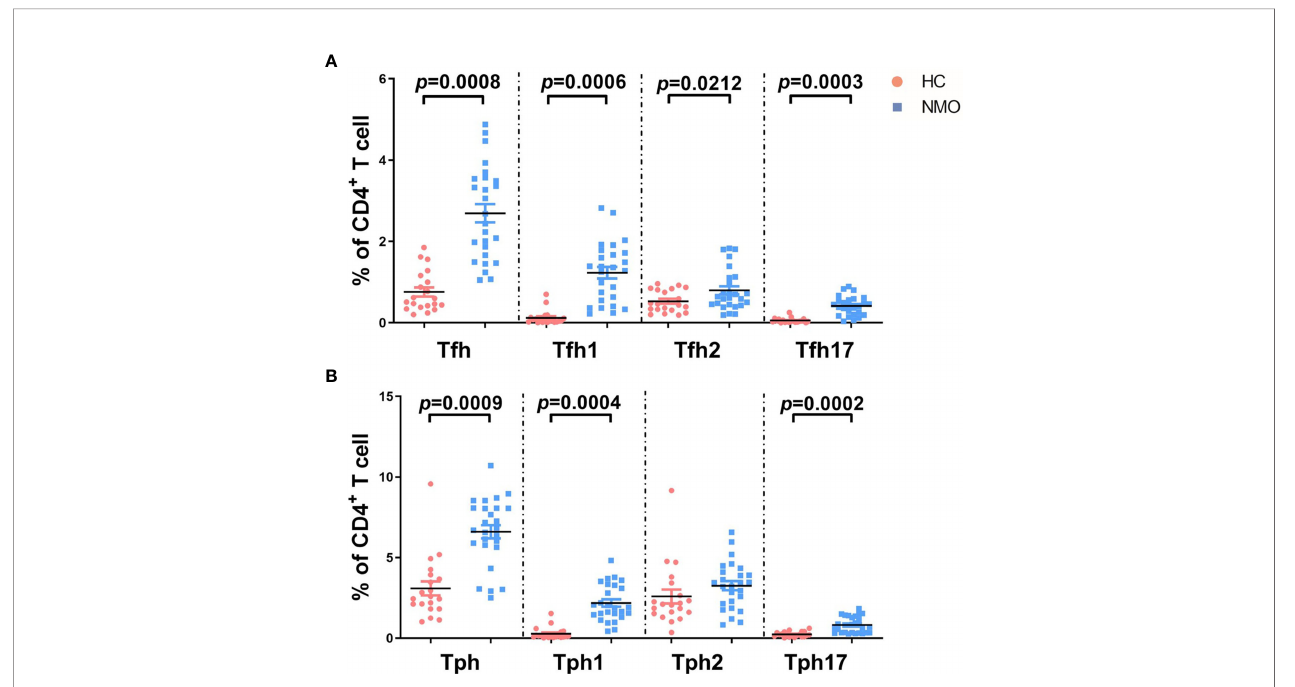
FIGURE 3 | The comparison of T cell subsets distribution in healthy controls and patients with NMOSD. (A) Proportions of T follicular helper (Tfh: CD4 + CXCR5 + PD- 1 high ) and subsets among total CD4 + cells in patients with NMOSD and healthy controls (HC); (B) Proportions of peripheral T helper (Tph: CD4 + CXCR5 - PD-1 high ) and subsets. Tfh1 (CXCR3 + CCR6 – ), Tfh2 (CXCR3 – CCR6 – ), and Tfh17 (CXCR3 – CCR6 + ), Tph1 (CXCR3 + CCR6 – ), Tph2 (CXCR3 – CCR6 – ), and Tph17 (CXCR3 – CCR6 + ). Unpaired, two-tailed Student ’ s t tests were used. HC: n=20; NMOSD: